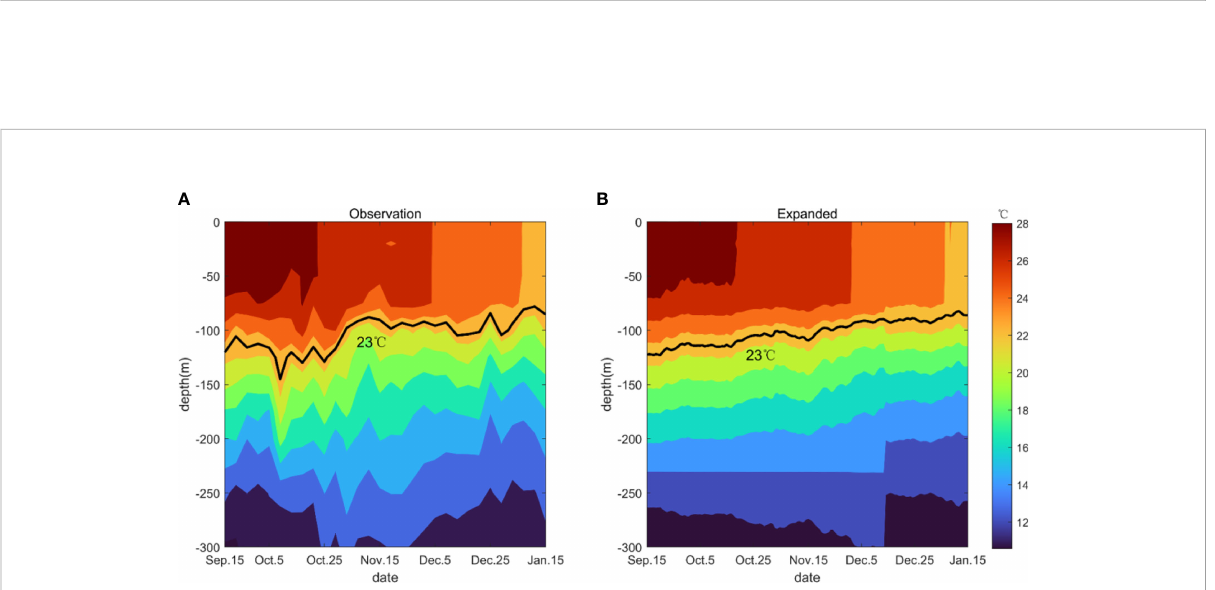
FIGURE 15 Temperature pro fi les corresponding to the black squares in Figure 14 based on the observation data (A) and the expanded temperature fi eld (B) , respectively. The black lines are isotherms of 23°C used as a thermocline proxy and the interval bewewen color contours is